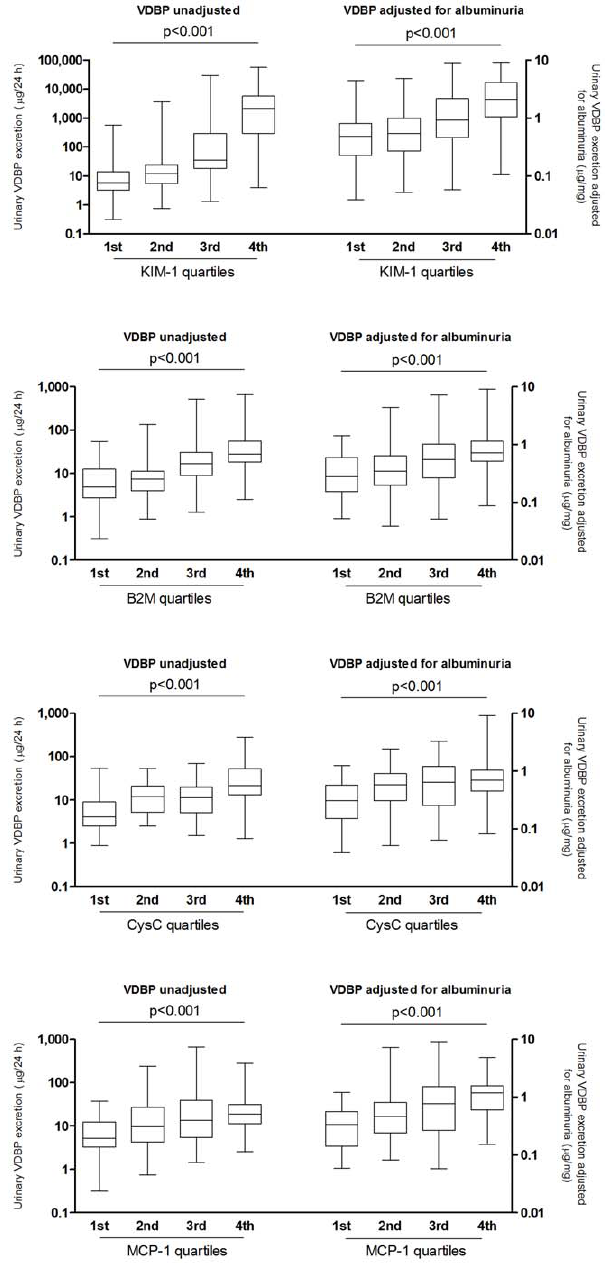
Figure 4. Urinary vitamin D binding protein (uVDBP) and established renal tubular damage markers in patients with renal damage. Box-whisker plots illustrating the relation between uVDBP and established renal tubular damage markers kidney injury molecule-1 (KIM-1) (A), beta-2-microglobulin (B2M) (B), Cystatin C (CysC) (C) and monocyte chemoattractant protein-1 (MCP-1) (D) in normo- and microalbuminuric subjects (both n=100). The uVDBP is presented per quartile of the established renal damage marker studied. In all panels (A-D), the left four box whisker plots represent the unadjusted VDBP excretion, and the right four box whisker plots represent the uVDBP adjusted for albuminuria. All biomarkers are positively associated with uVDBP, also when VDBP was adjusted for albuminuria (p , 0.001, Kruskal Wallis).